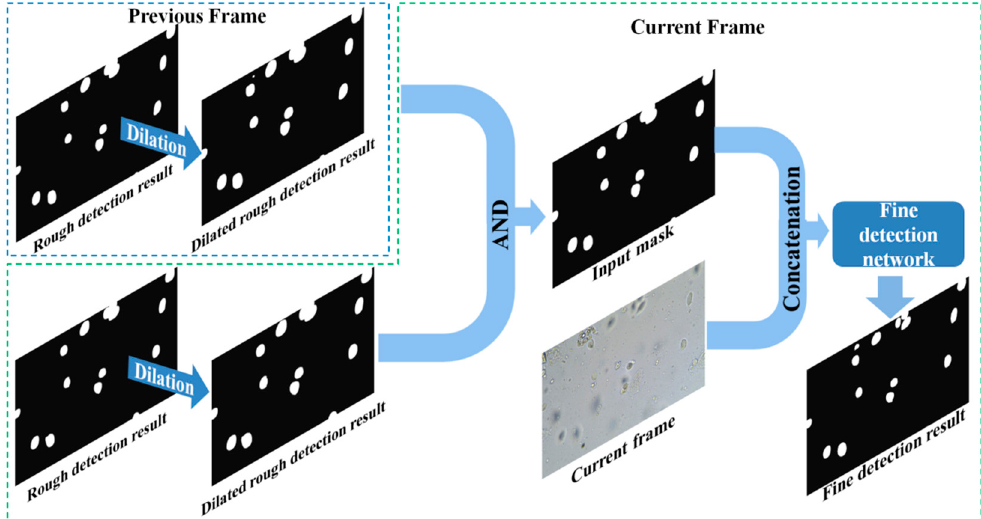
Figure 5. The inference phase of the fine detection network.